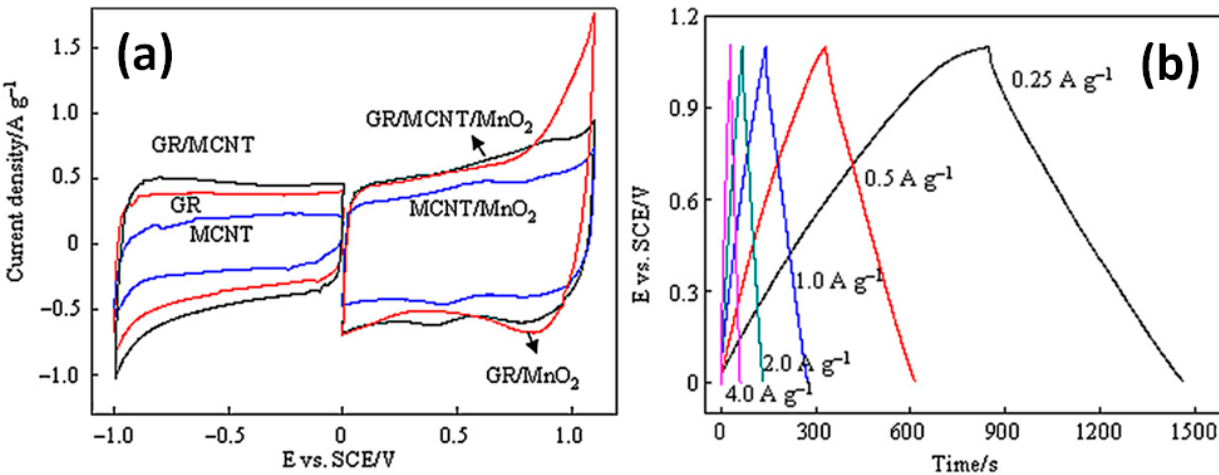
Figure 22. CV curves of electrodes made of rGO (mentioned as GR), on multiwall CNT (here as MCNT), their combination GR/MCNT (a, left), and their composite with MnO 2 (GR/MCNT/MnO 2 ) as well as GR/MnO 2 and MCNT/MnO 2 at a scan rate of 5 mV/s ( a ). GCD curves of GR/MCNT/MnO 2 at different current densities ( b ) (Reproduced with permission of [51]. Copyright Elsevier, 2012).